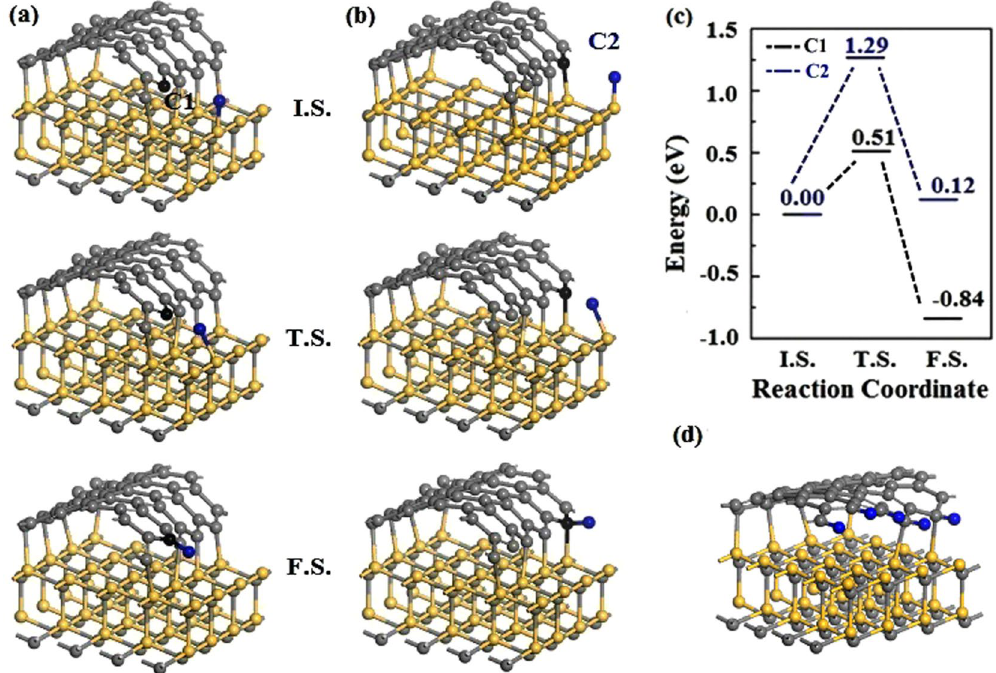
Figure 3. Reaction pathways for H diffusion to the site C1 ( a ) and C2 ( b ) on graphene edge. ( c ) Energy barriers for H diffusions. ( d ) Atomic structure of SiC and graphene system with full passivated graphene edge. The blue balls denote the H atoms, the black and gray balls denote the C